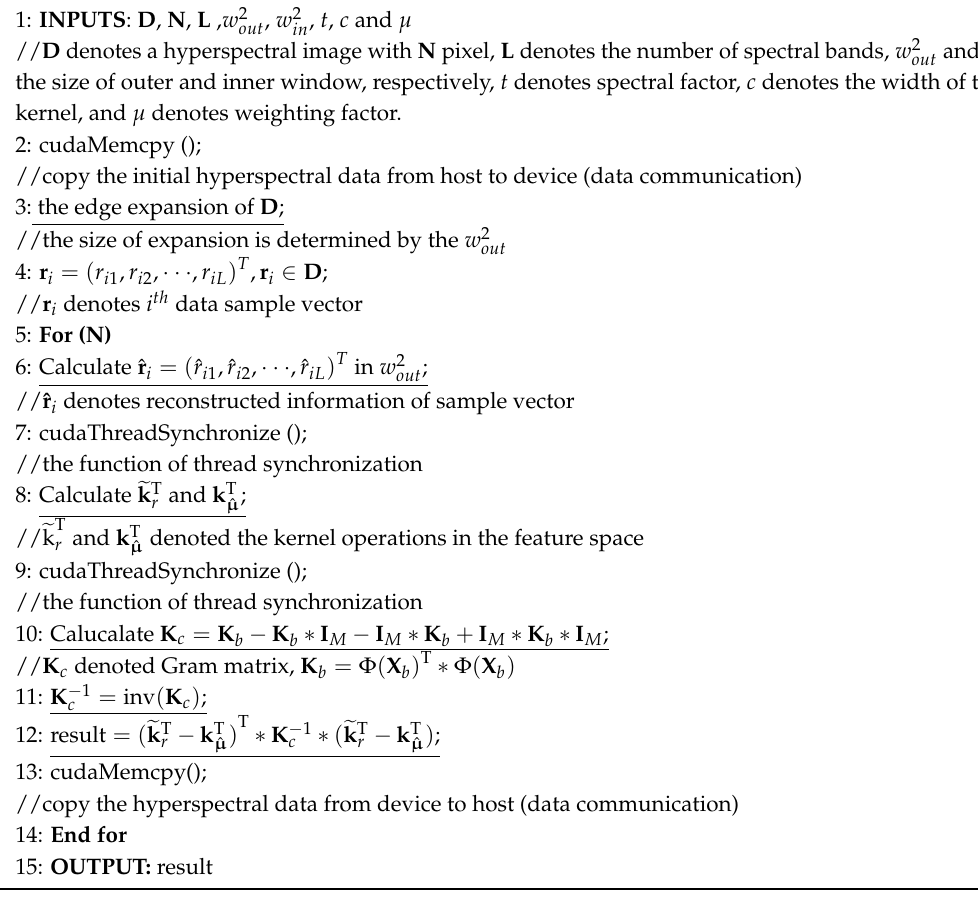
Algorithm 1. CUDA Pseudo-Code of